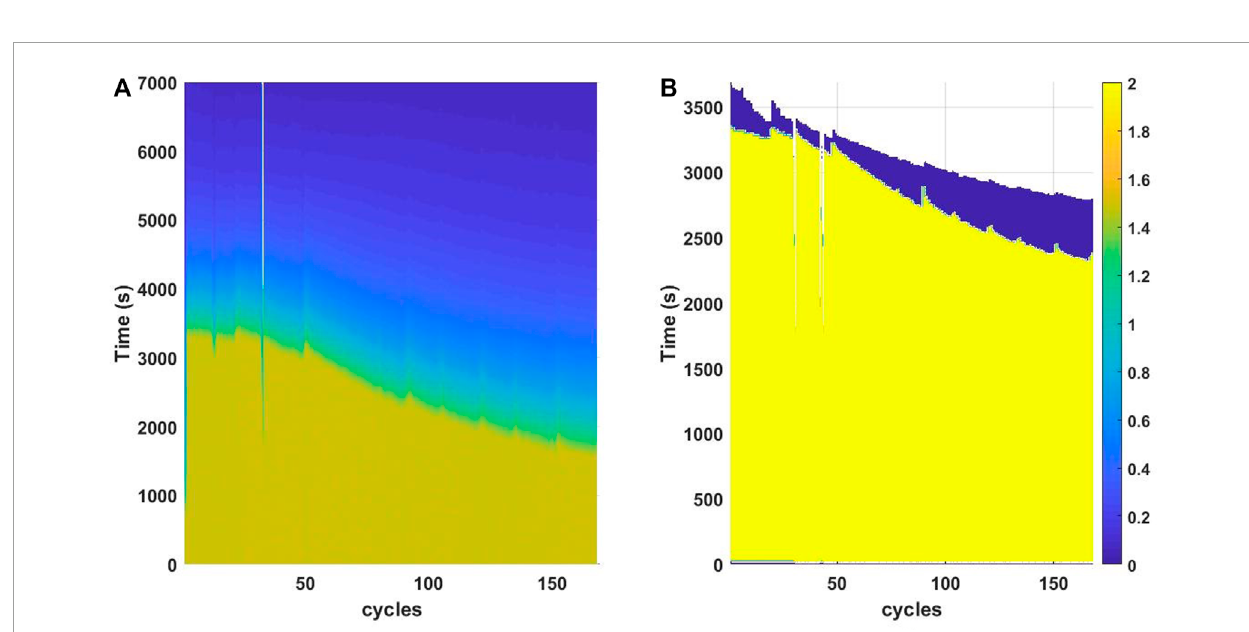
FIGURE 4 Battery output current in relation to time and number of cycles during (A) charging and (B) discharging cycle (absolute values are plotted, in actual the discharging current has negative values).